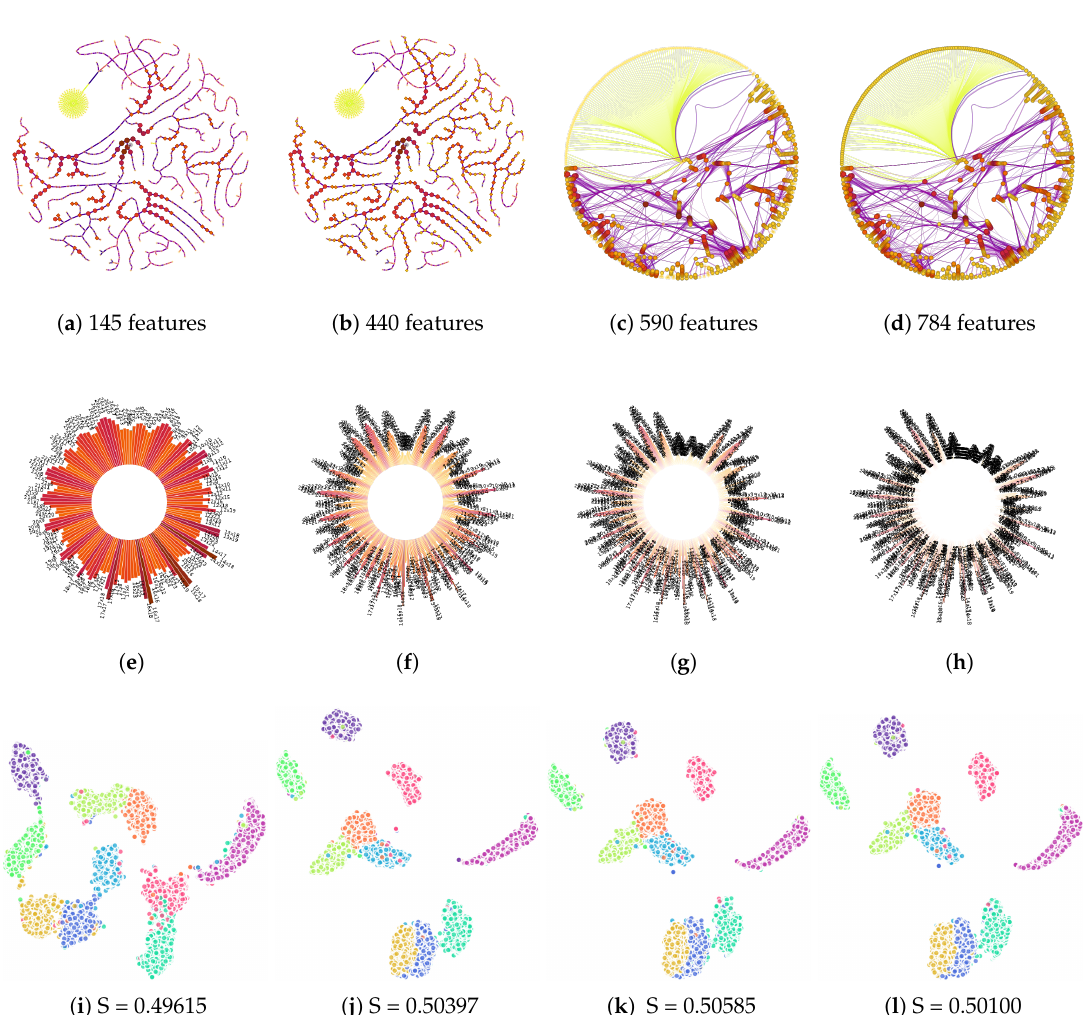
Figure 9. MNIST dataset with 10 classes (digits). ( a , b ) MST layouts by force-based placement, highlighting an increasingly larger set of features selected by ranked correlation. ( c , d ) Graph layouts with placement by circular tree layout from a minimum spanning tree, highlighting an increasingly larger set of features selected by ranked correlation. ( e – h ) Circular histogram of the selected features. ( i – l ) UMAP projection of the 10,000 data points generated from the space formed by selected features, with corresponding silhouette